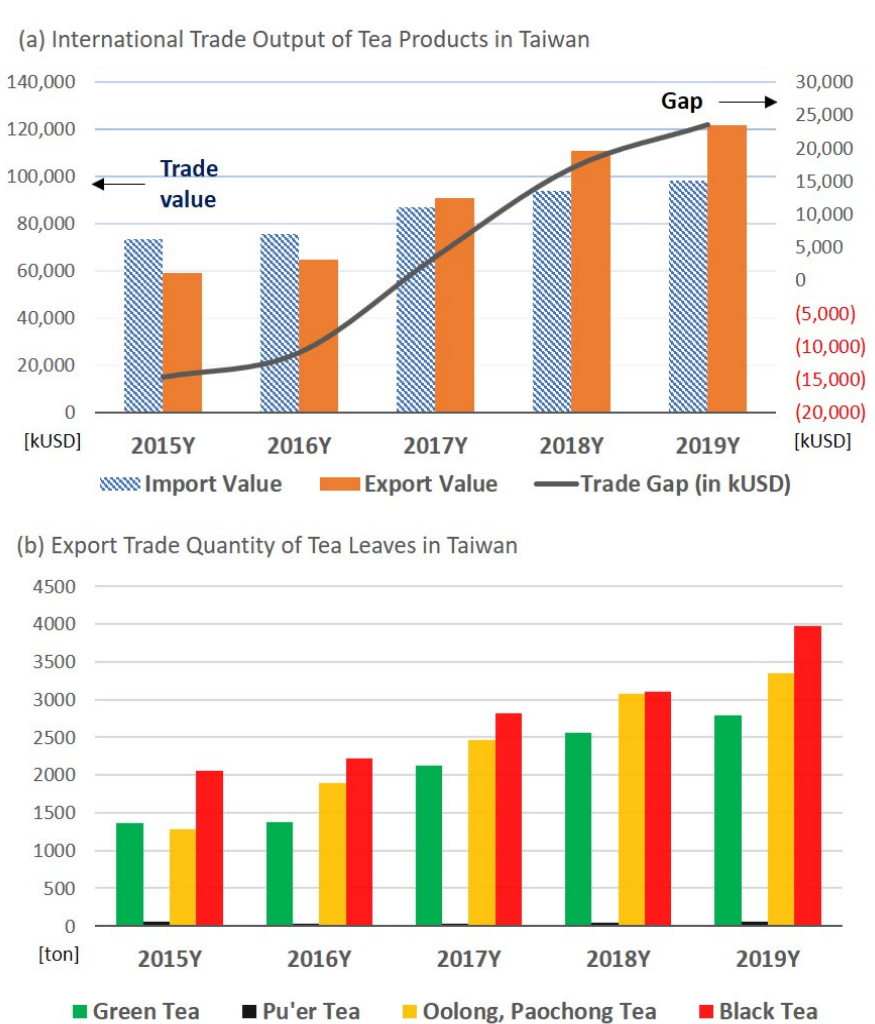
Figure 6. The international trade of Taiwan tea: ( a ) values of foreign exports, imports, and gap (red numbers show the deficit values) for 2015–2019; and ( b ) quantity of four sub-items of foreign exports. The import and export volumes of tea are based on pure tea leaves, and exclude tea extracts or related products. The data source is the tea industry trade union in Taiwan (2020).